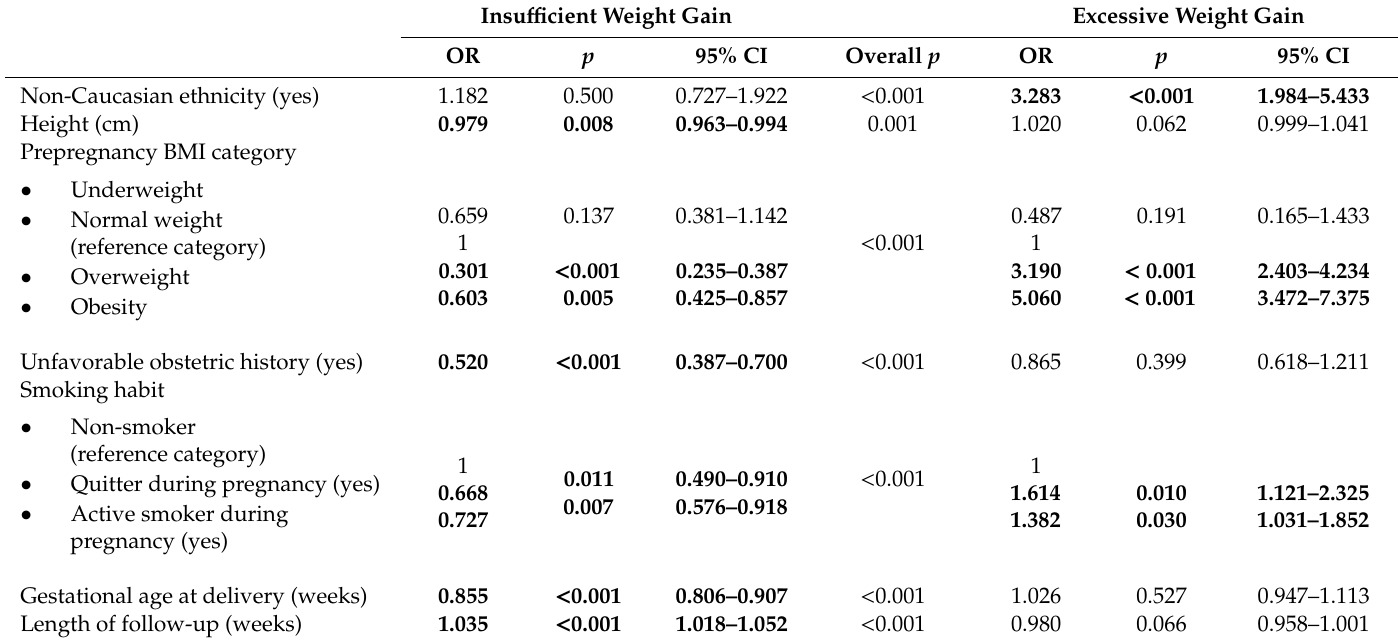
Table 2. Independent variables for insu ffi cient or excessive gestational weight gain according to IOM 2009 (multinomial multivariate logistic regression